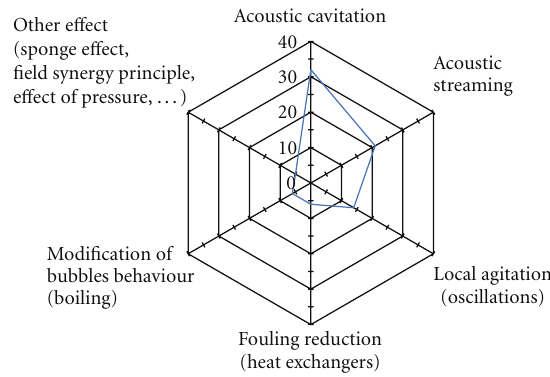
Figure 11: Ultrasound e ff ects held responsible for heat transfer en-